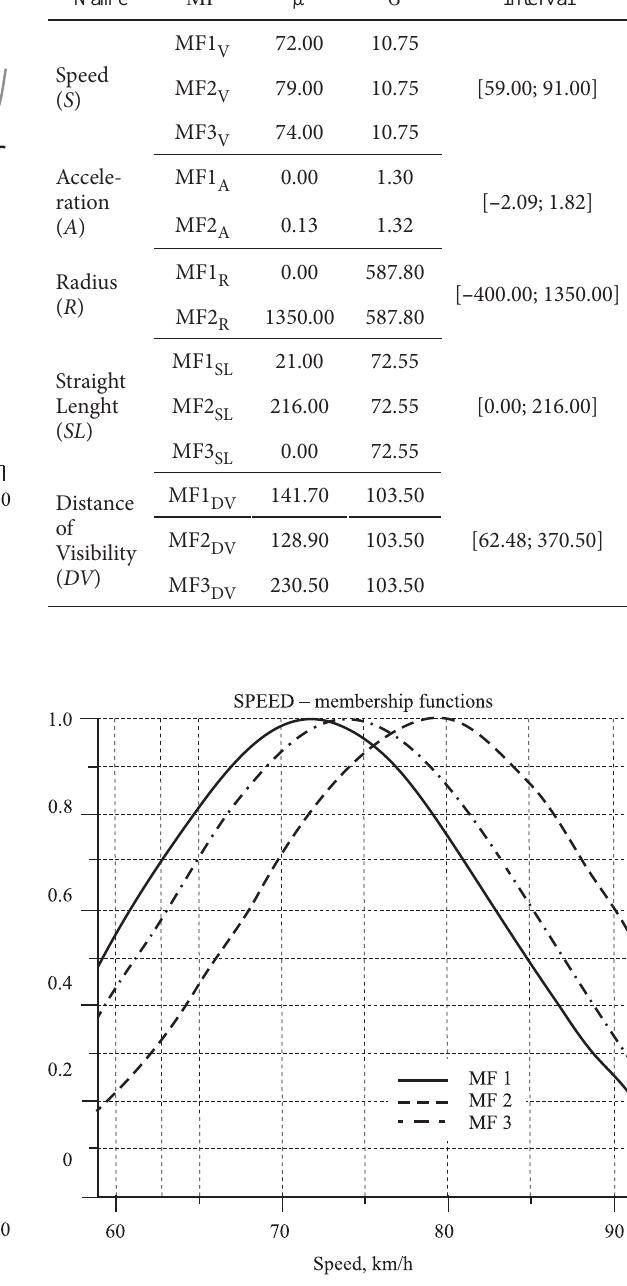
Fig. 6. Membership functions of the input variable speed